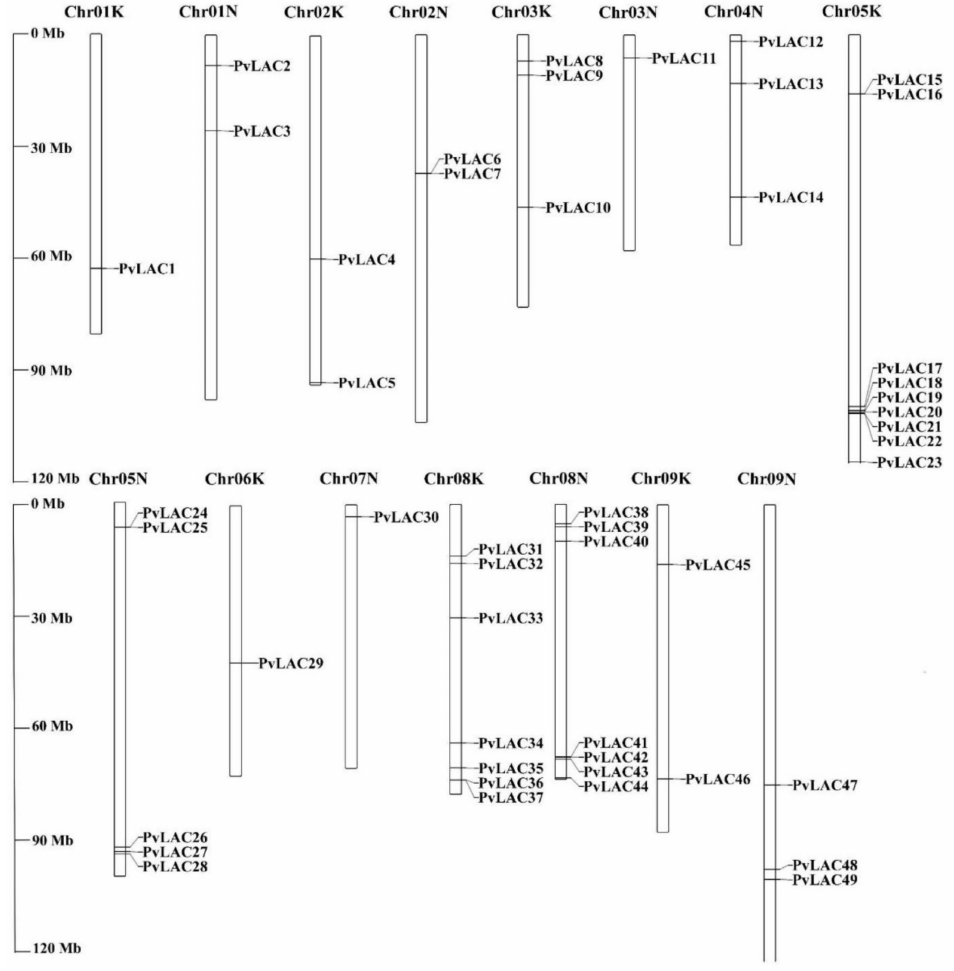
Figure 1. Chromosomal localization of switchgrass laccase gene family. The chromosomal localization of PvLac genes was based on the information provided in Phytozome v12.0. ChrK and ChrN are two sets of subgenomes of switchgrass (2n = 4x = 36). The scale bar is shown on the